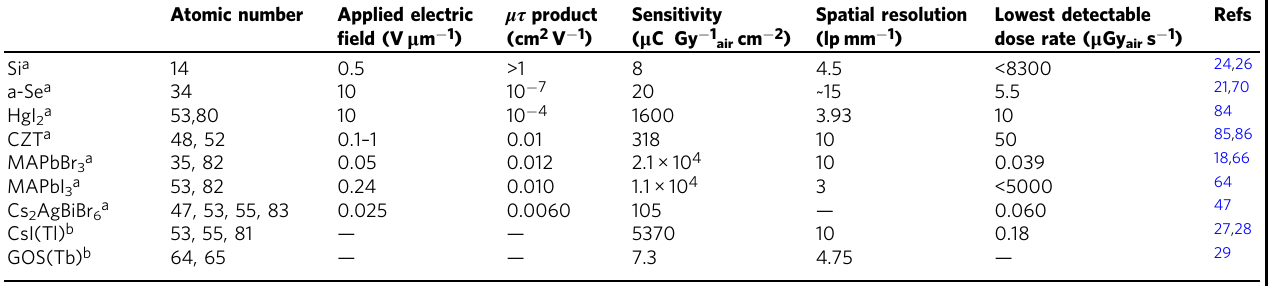
Table 1 Performance of conventional X-ray detectors for medical imaging Atomic